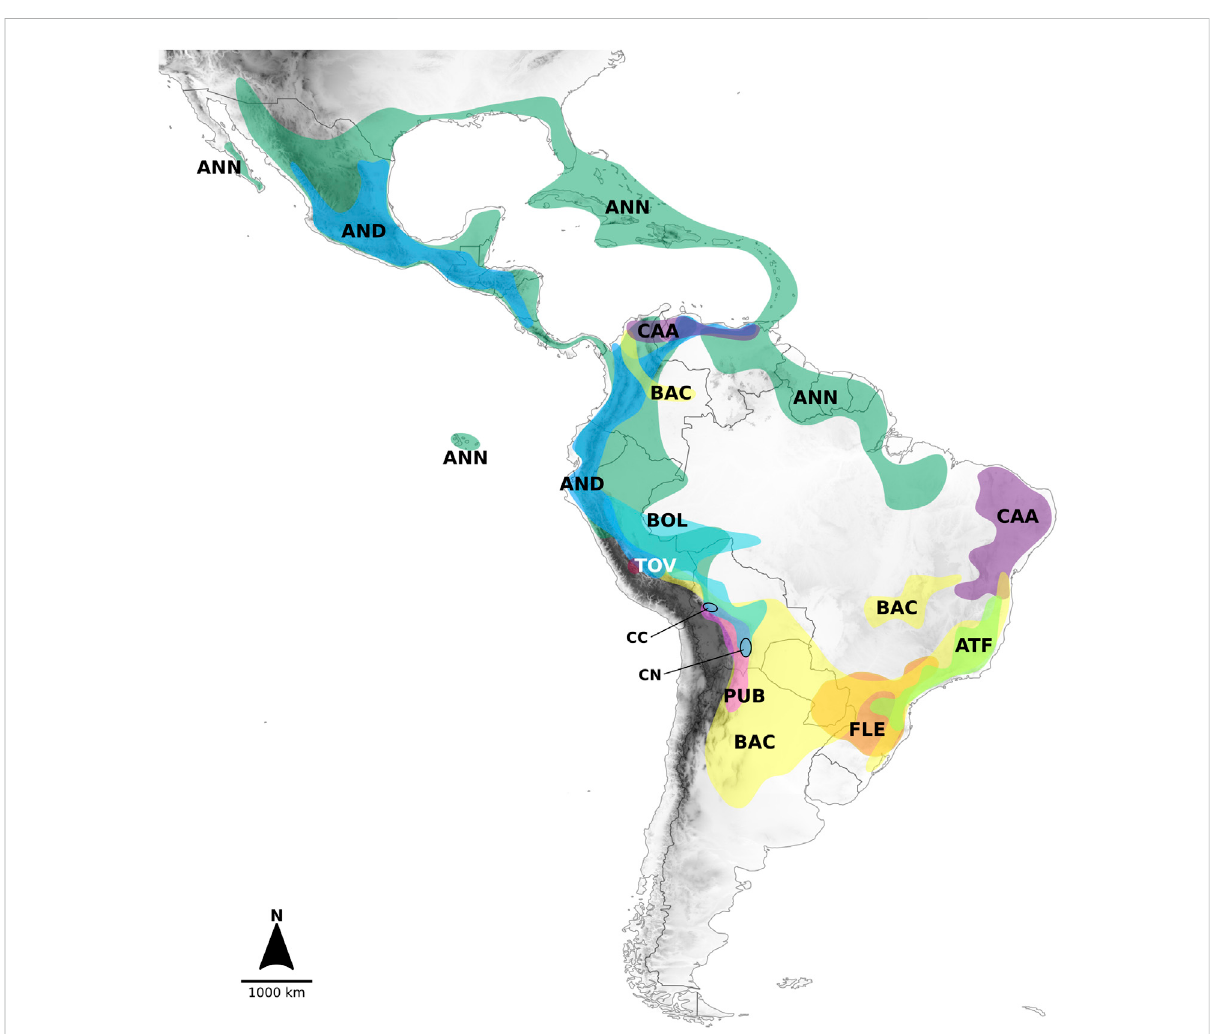
FIGURE 2 Geographic distribution of the clades recognized in Capsicum , including only wild taxa. Distributions outlined according to collection data presented in Barboza et al. (2022). Colors correspond to Figure 1 and Supplementary Figure S2. Legends: AND. Andean clade, ANN. Annuum clade, ATF.AtlanticForestclade,BAC.Baccatumclade,BOL.Bolivianclade,CAA.Caatingaclade,FLE.Flexuosumclade,PUB.Pubescensclade,TOV.Tovarii clade, species not assigned to any clade = CC. C. coccineum , CN. C. neei